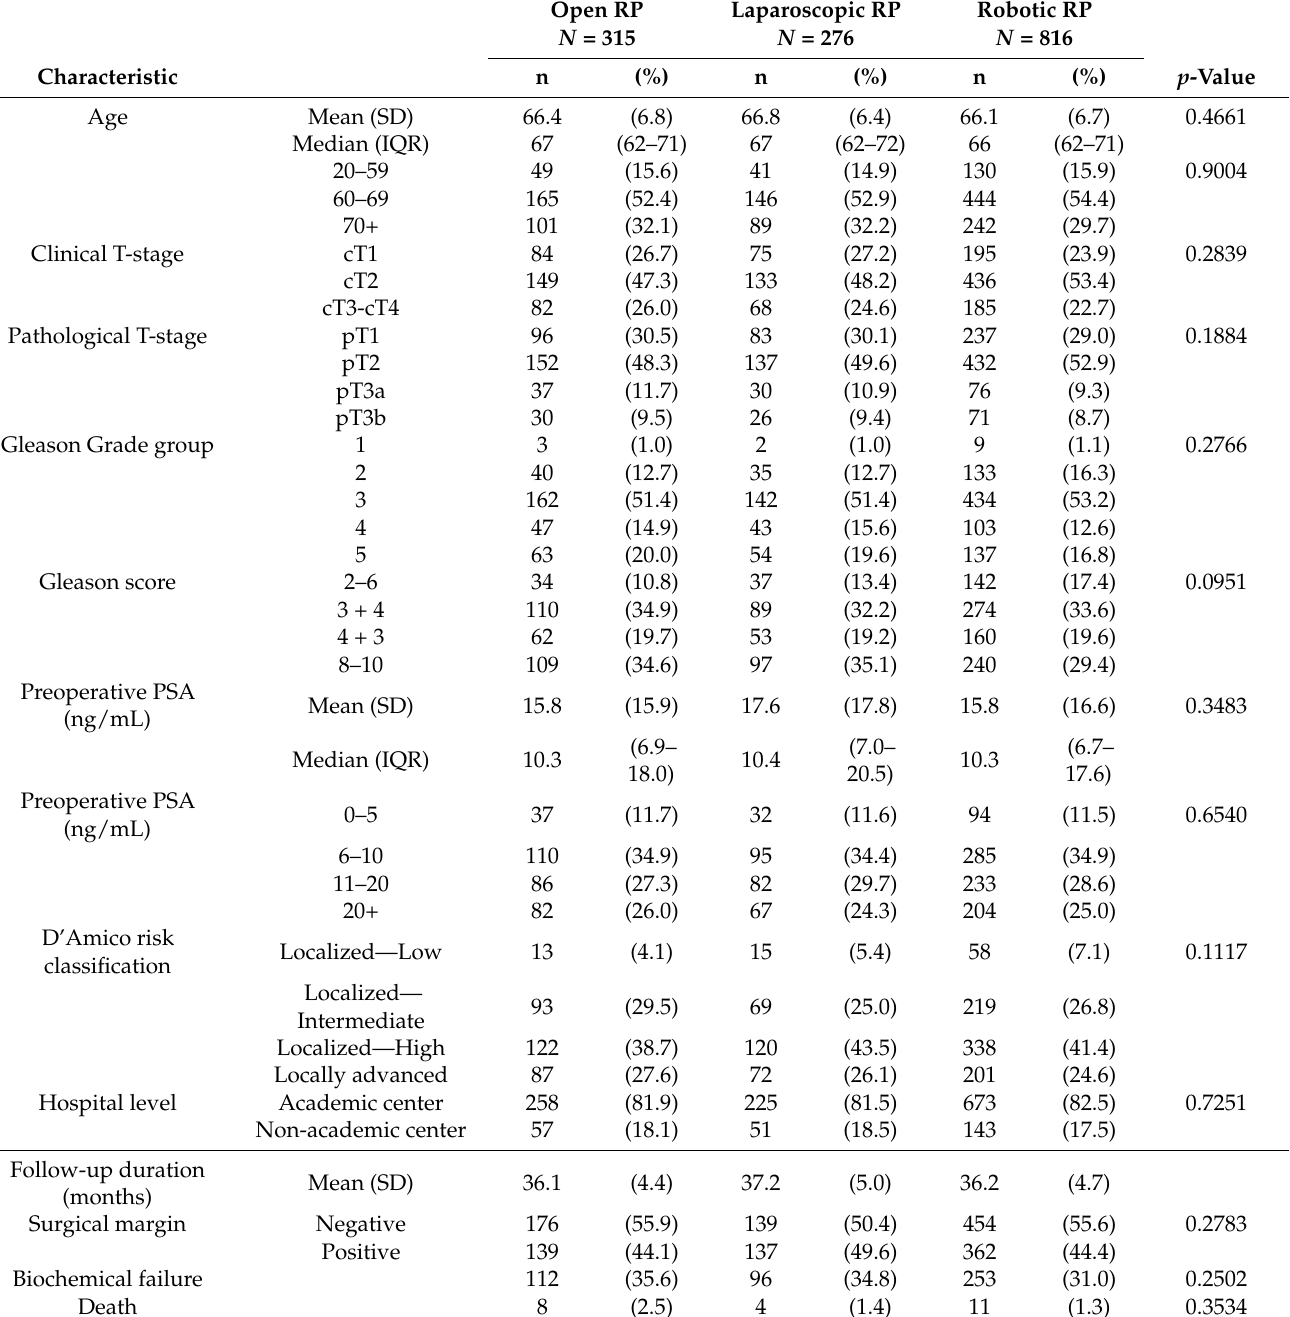
Table 1. Demographic and Clinicopathological Characteristics, Stratified by Surgical